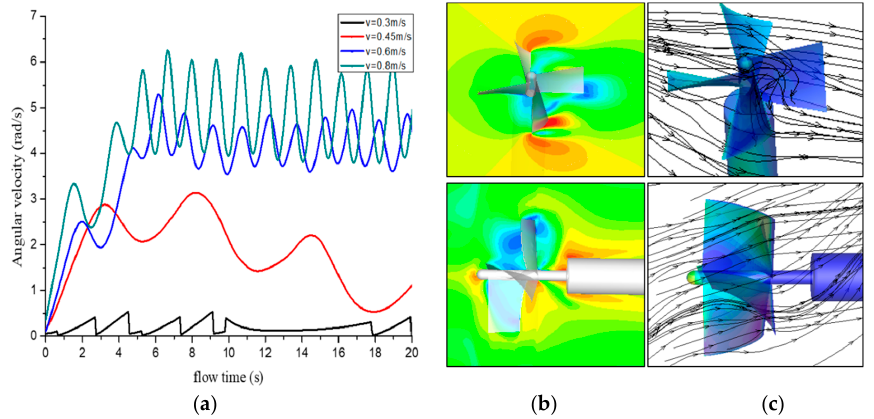
Figure 7. ( a )Time-domain curves of angular velocity at different flow velocities; ( b ) Velocity profile of the cross section of the flow field around the turbine at a certain time; ( c ) A streamline diagram of the velocity field around the turbine at a certain time.